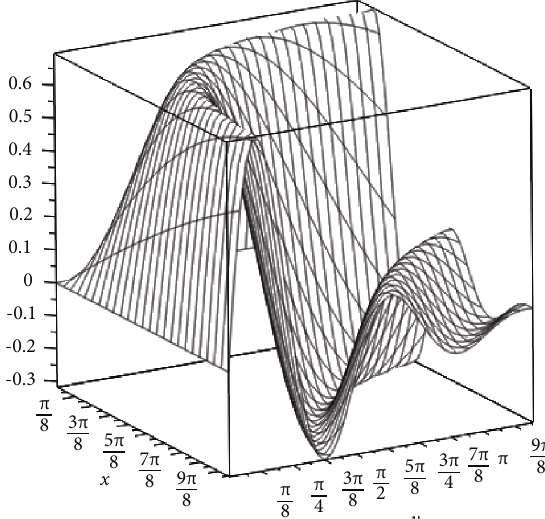
Figure 12: Example of a surface with more than one